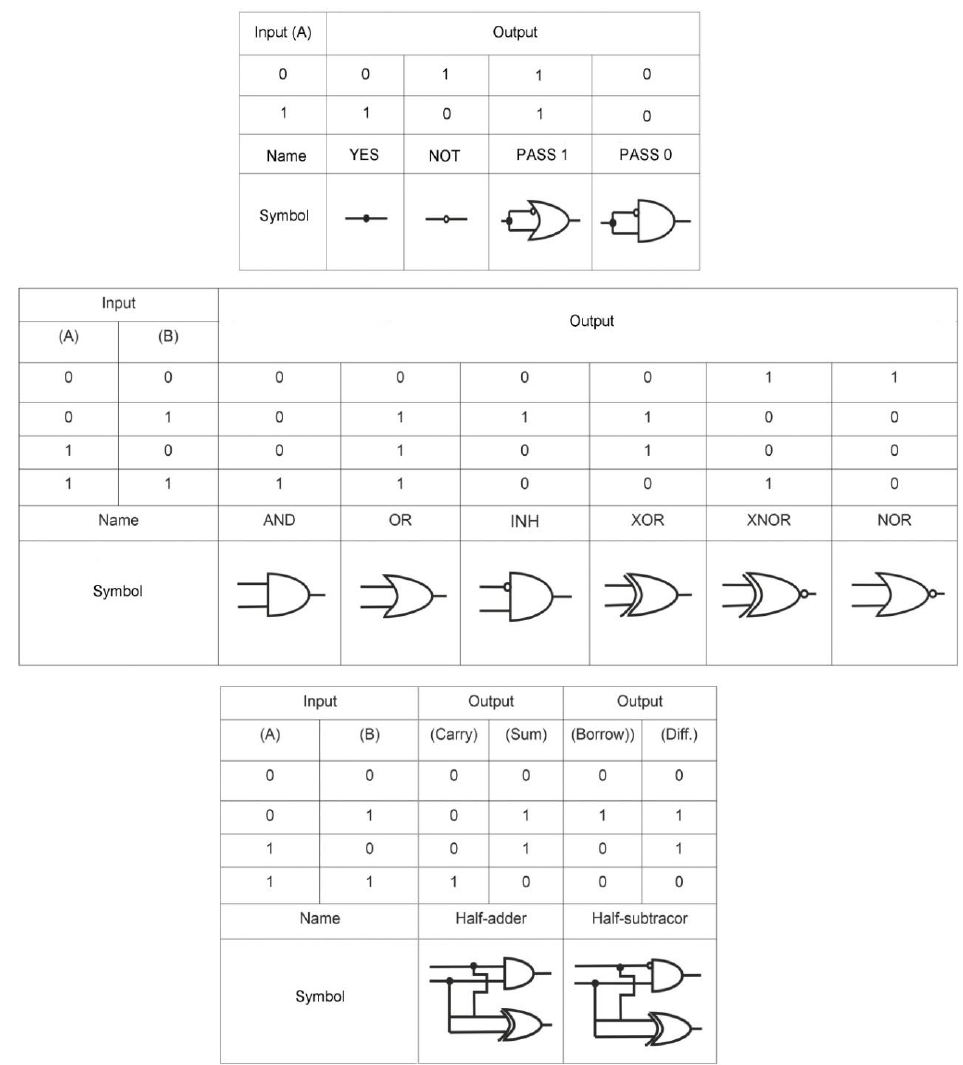
Figure 1. Logic gates: inputs A , B (0, 1), outputs (0, 1) and symbols.